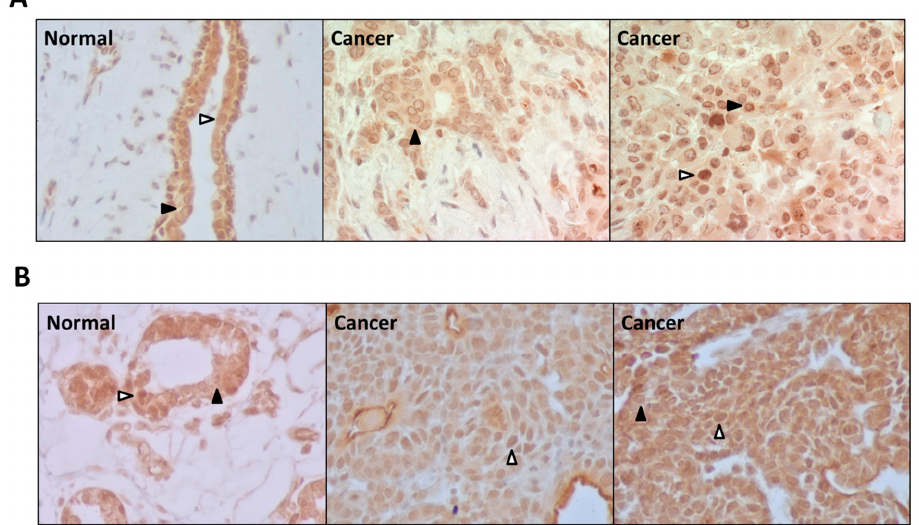
Figure 5. Immunohistochemical evaluation of PDE5 expression in noncancerous and cancerous breast tissue samples, 400× magnification. ( A ) Human breast tissue samples include uninvolved breast tissue from a patient diagnosed with breast cancer (left) and cancerous biopsy samples from different patients (middle, right). ( B ) Sprague-Dawley rat mammary tissue samples include noncancerous tissue from a rat not exposed to MNU (left) and cancerous tissue from two separate rats after exposure to MNU (middle, right). Black arrowheads ( ) indicate diffuse cytosolic and nuclear staining with marked perinuclear localization. White arrowheads ( ) indicate predominantly nuclear staining with minimal cytosolic labeling.